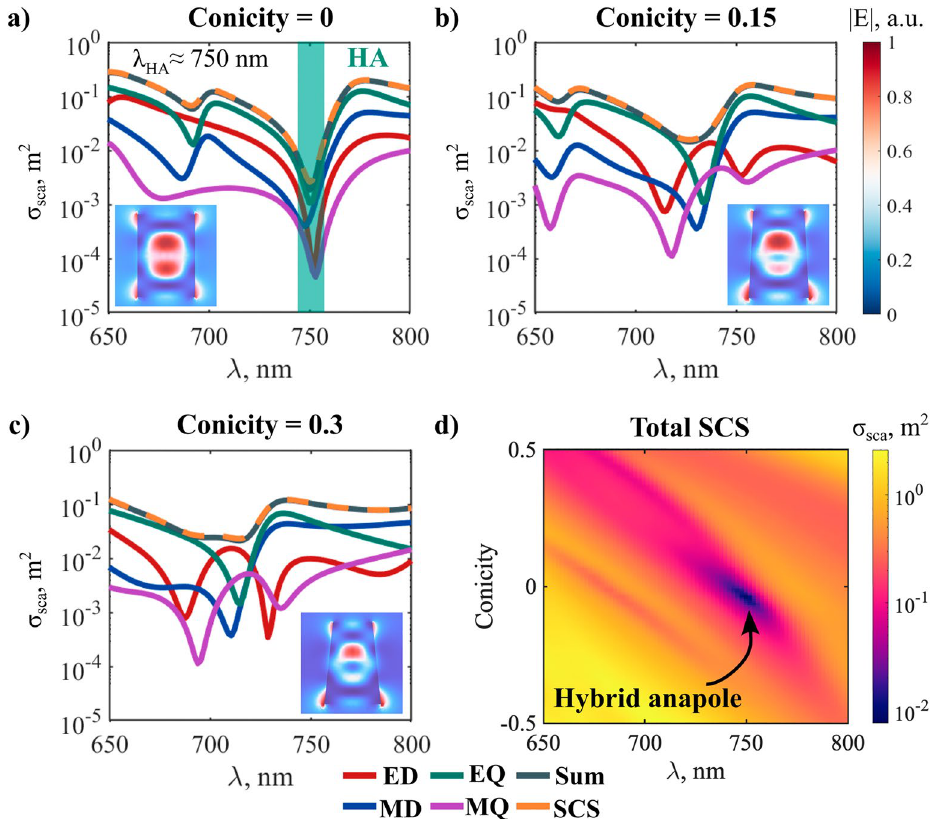
Figure 5. Evolution of the HA as a function of conicity and wavelength. ( a – c ): Multipole decompositions of the SCS (semilogarithmic scale) for selected conicities (see geometric parameters of HA in section S3 of the Supplementary Information). In all calculations, the height of the nanoparticle was kept constant. Insets: distribution of the electric field norm at λ HA ( d ): Total SCS as a function of conicity and wavelength. The experimental dispersion data for a-Si is shown in Supplementary Fig.